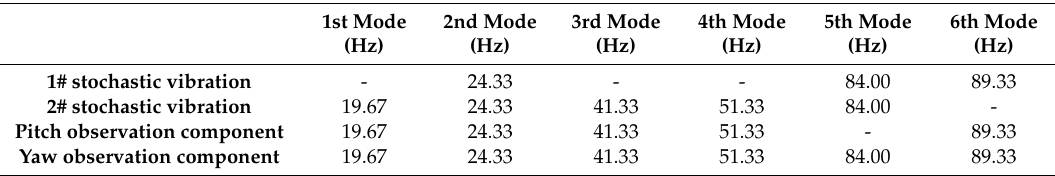
Table 3. Comparison results at Ma = 0.6.